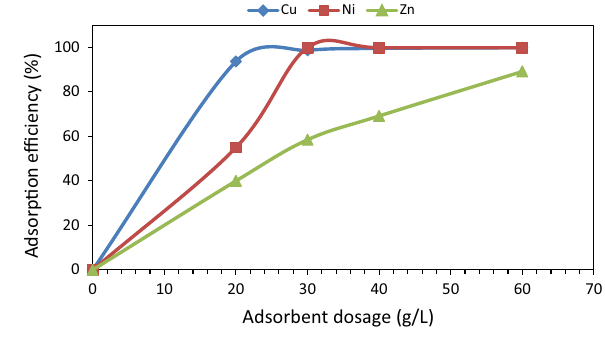
Fig. 1 Adsorption of heavy metals (copper, nickel and zinc) on ben-